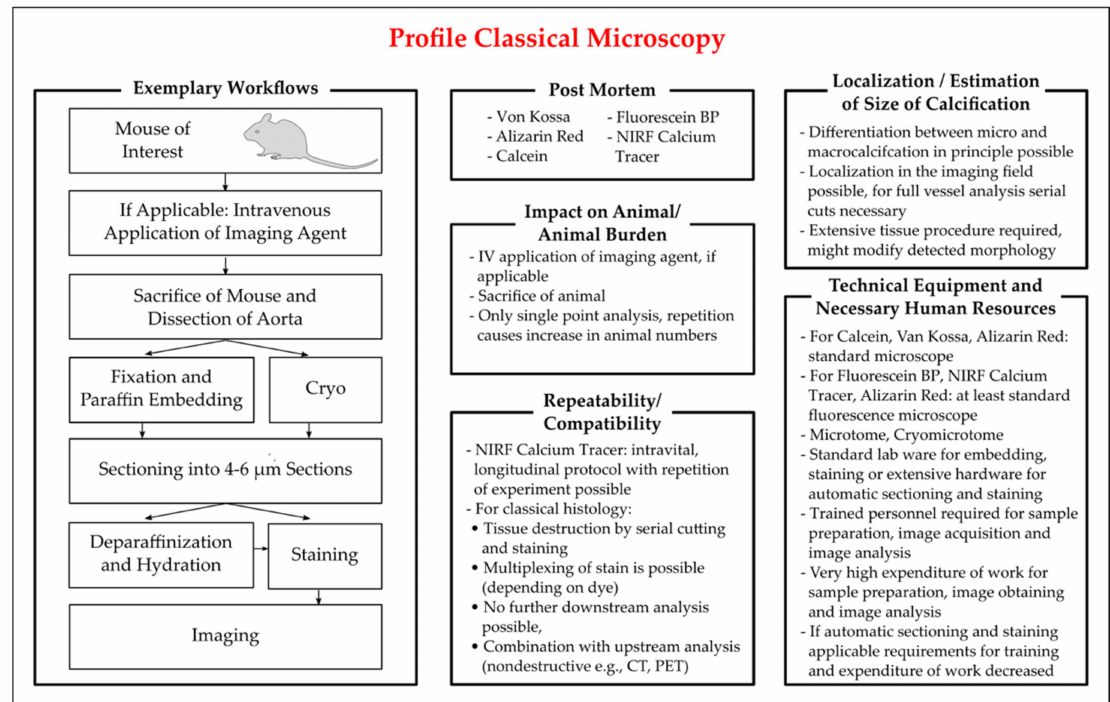
Figure 1. Characteristics of methods of classical microscopy employed for the detection of vascular calcification in mice. Key aspects for the critical appraisal of the applicability of classical histology are summarized with regard to the applicability of classical histology in vivo and ex vivo, the identifiable location and size of vascular calcification, the repeatability of analysis in longitudinal studies, the compatibility with additional methods, and the personal and technical expanse. The exemplary workflow presented is based on the publications of